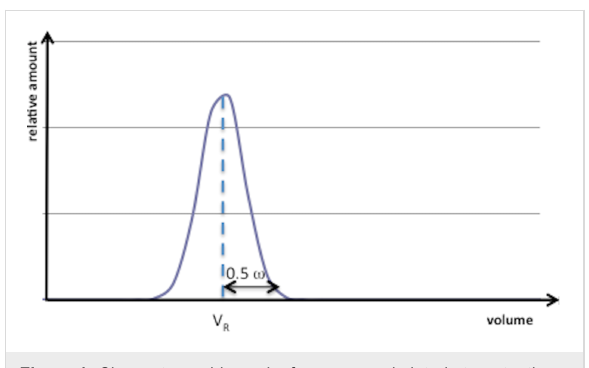
Figure 1: Chromatographic peak of a compound eluted at a retention volume V R with a width ω .